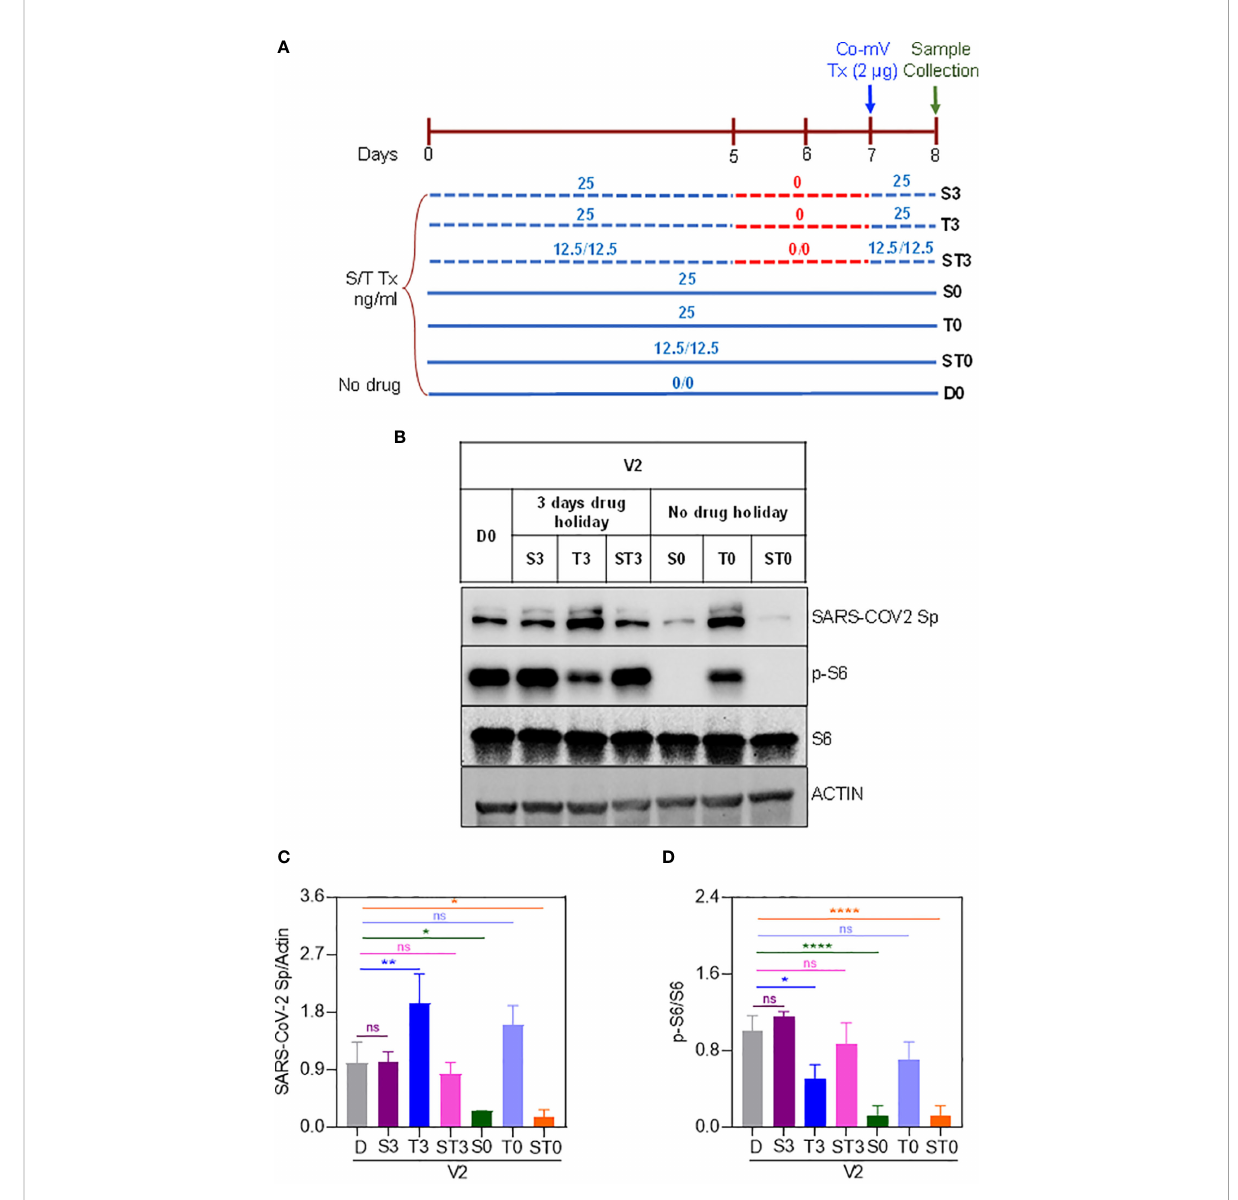
FIGURE 9 Three-days complete holiday of drug(s) rescued the drug-induced repression of spike protein expression in Co-mV transfected HEK293 cells in vitro . (A) 8-day experimental schema to assess three-day complete holiday of drugs, which included the following 7 groups: D0, S0, T0, ST0, S3, T3, and ST3. (B) The drug combinations were pretreated and maintained for 8 days except for 3-days complete holiday starting day 5 through day 7. All the groups received 2 m g of P fi zer BioNTech Co-mV on the 7 th day. The individual concentrations of T and S and their combinations were 25, 25, and 12.5 ng/mL each, respectively. At the end of 8 th day, protein lysates were collected from all the groups, and Western analysis were performed for the expression of SARS-CoV-2 Sp, pS6, S6, and b -actin antibodies. A representative immunoblot from three independent experiments was shown. (C & D) Quanti fi cation of the immunoblots in panel (A) expressed as a ratio of SARS-CoV-2 Sp to Actin; and phospho- speci fi c protein S6 to total S6, respectively. Relative values to DMSO controls were shown. Data was expressed as the mean ± SD (n=3) and the statistical inferences between DMSO and treatment groups were made from one-way ANOVA, Tukey post-hoc multiple comparisons. (In panel (C) , * p = 0.04 (D vs S0); * p = 0.02 (D vs ST0); ** p = 0.009; In panel (D) , * p = 0.02 (D vs T3); **** p < 0.001, ns – not signi fi cant, as indicated). Co-mV, COVID-19 mRNA vaccine; V2, 2 m g of P fi zer BioNTech Co-mV; S, sirolimus; T, tacrolimus; Tx, treatment; Group D0, DMSO and no drug; Group S0, Tx with only S for 8 days with no interruption; Group T0, Tx with only T without drug stoppage; ST0, Tx with S and T combination without drug holidays; Group S3, Tx with only S with 3 days drug stoppage; Group T3, Drug T with a transient halt of drug treatment for 3 days; ST3, Tx with S and T combination with a continuous interruption of drugs for 3 days; SARS-CoV-2 Sp, severe acute respiratory syndrome coronavirus 2 spike; S6, S6 ribosomal protein; pS6, phospho-S6 ribosomal